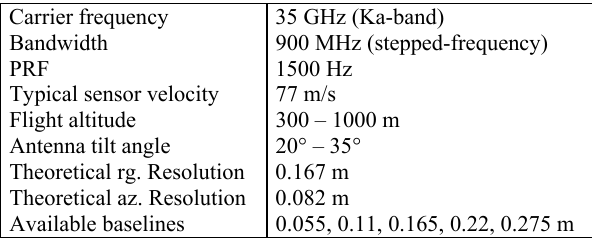
Table 1. MEMPHIS SAR system parameters.